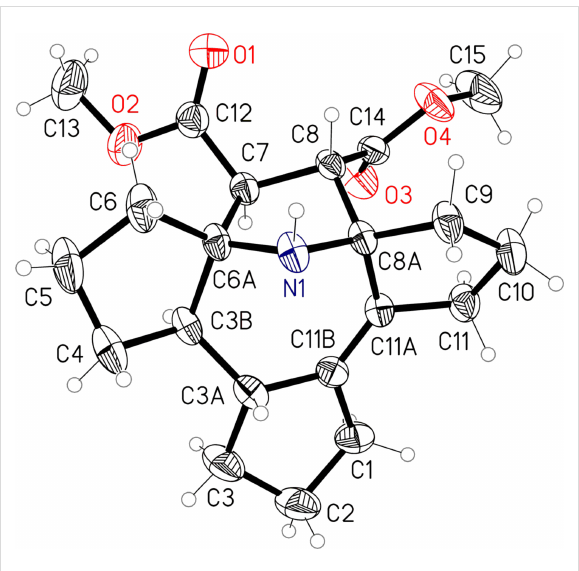
Figure 1: X-ray structure of compound 1 (one of the two enantiomers present in the crystal). It is well-known that cyclopentanone is prone to self-condensa- tion. In the presence of ammonia these reactions may lead to heterocycle formation [11]. Presumably, a prototropic shift in the enamine-imine intermediate 4 is followed by electrocycliza- tion to the cyclic azomethine ylide, which then reacts with dimethyl fumarate in a 1,3-dipolar cycloaddition. The sug- gested mechanism accounts for the trans -position of the methyne hydrogens in the azepine ring: electrocyclization proceeds via a conrotatory mechanism due to the antisymmetry of the HOMO (Figure 2).